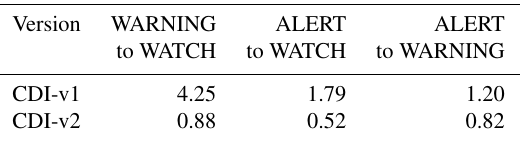
Table 2. Average percentage of cells in drought areas with sequenc- ing in contrast with the cause–effect relationship for the full Euro- pean